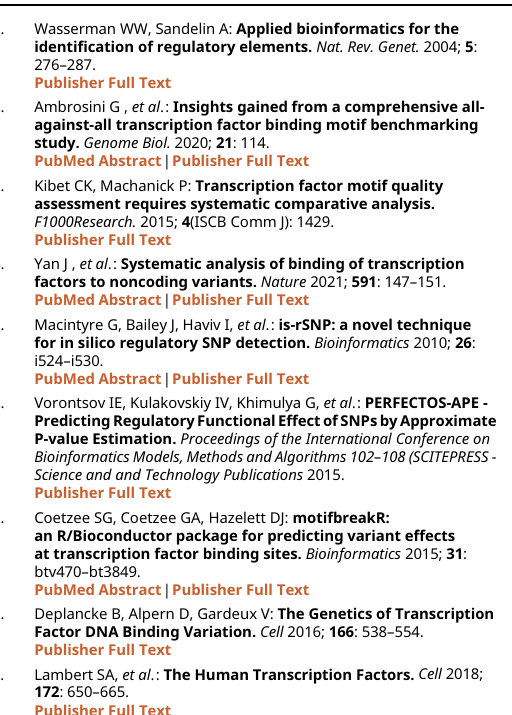
Data are available under the terms of the Creative Commons Zero “ No rights reserved ” data waiver (CC0 1.0 Public domain